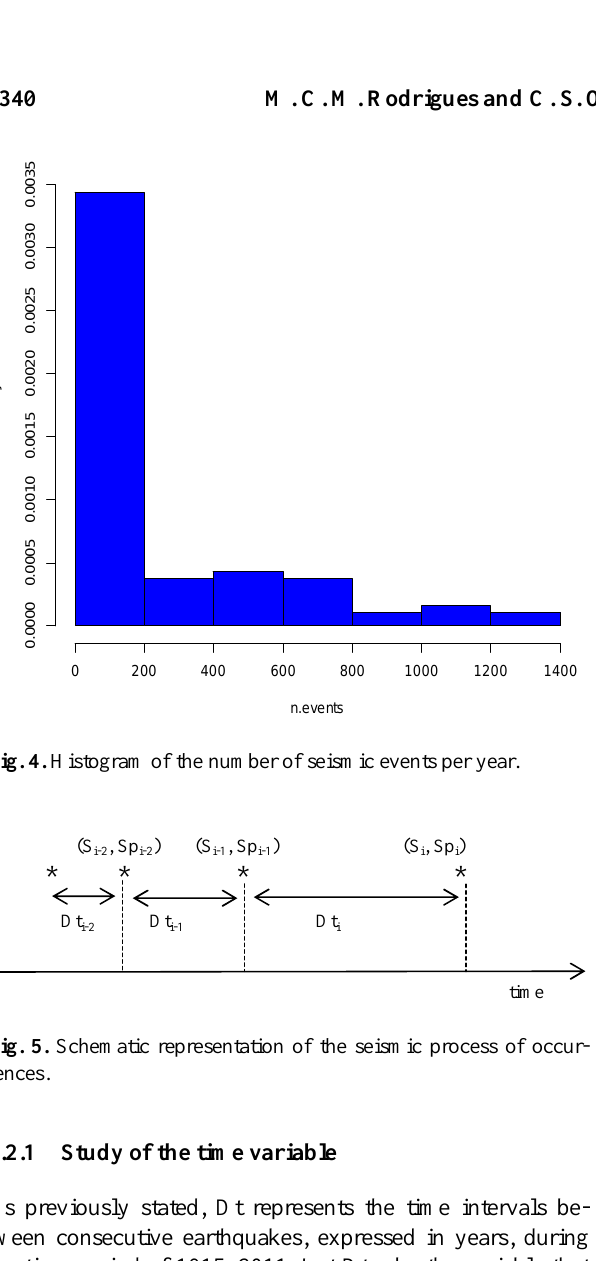
2 Figure 6a) Histogram of Dt; b) Histogram of Dt Fig. 6. (a) Histogram of Dt, and (b) histogram of Dt 60